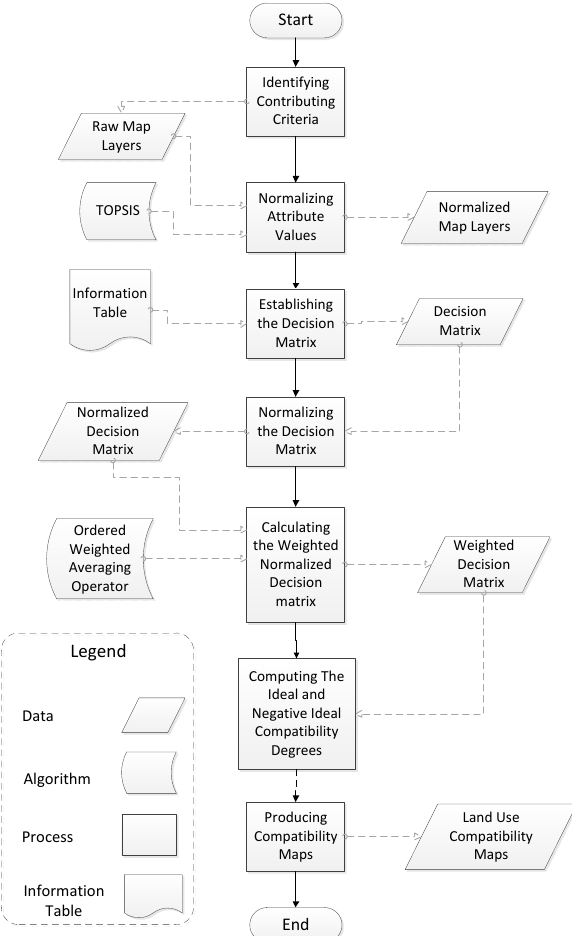
Figure 2. Steps of the proposed land use compatibility model